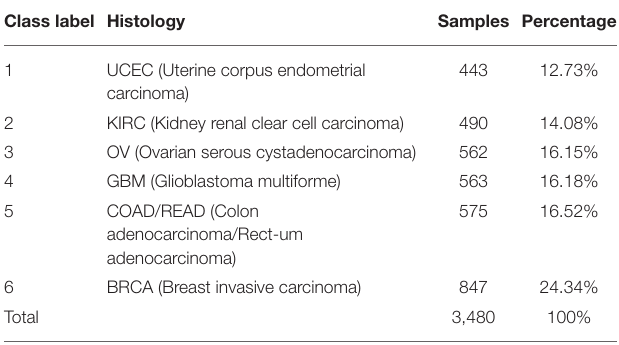
TABLE 1 | The number of samples for each cancer type in this